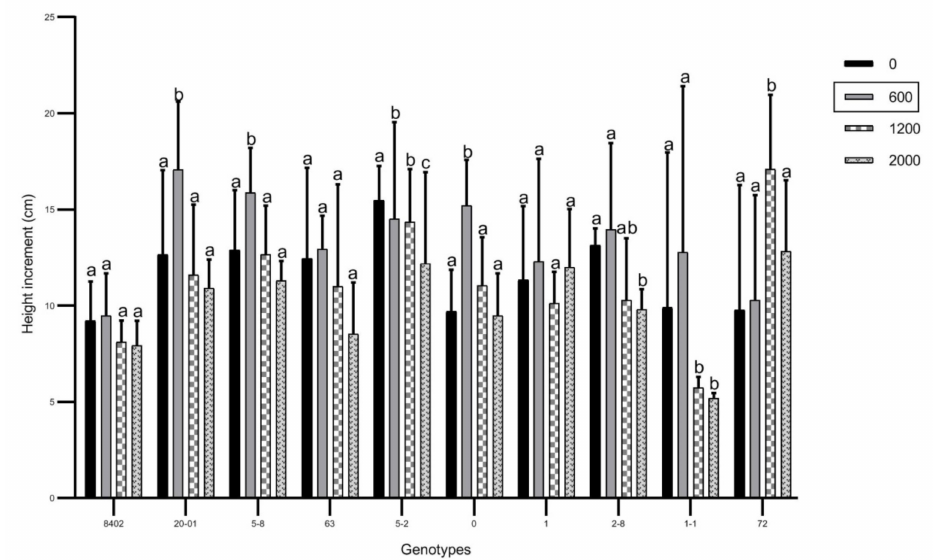
Figure 1. Effects of Sb concentration on height increment of Catalpa bungei. Note: Different letters indicate significant differences among the treatments at p < 0.05 ( n = 3). The same